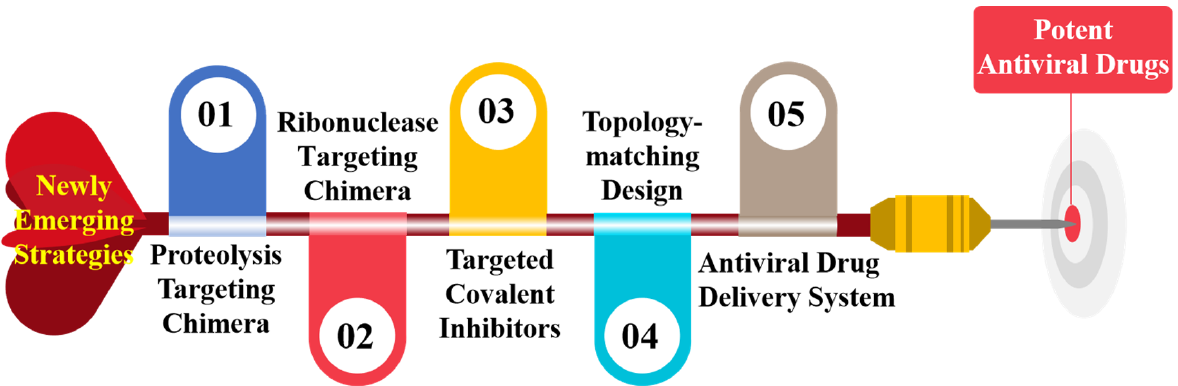
Figure 1. Newly emerging strategies in antiviral drug discovery.